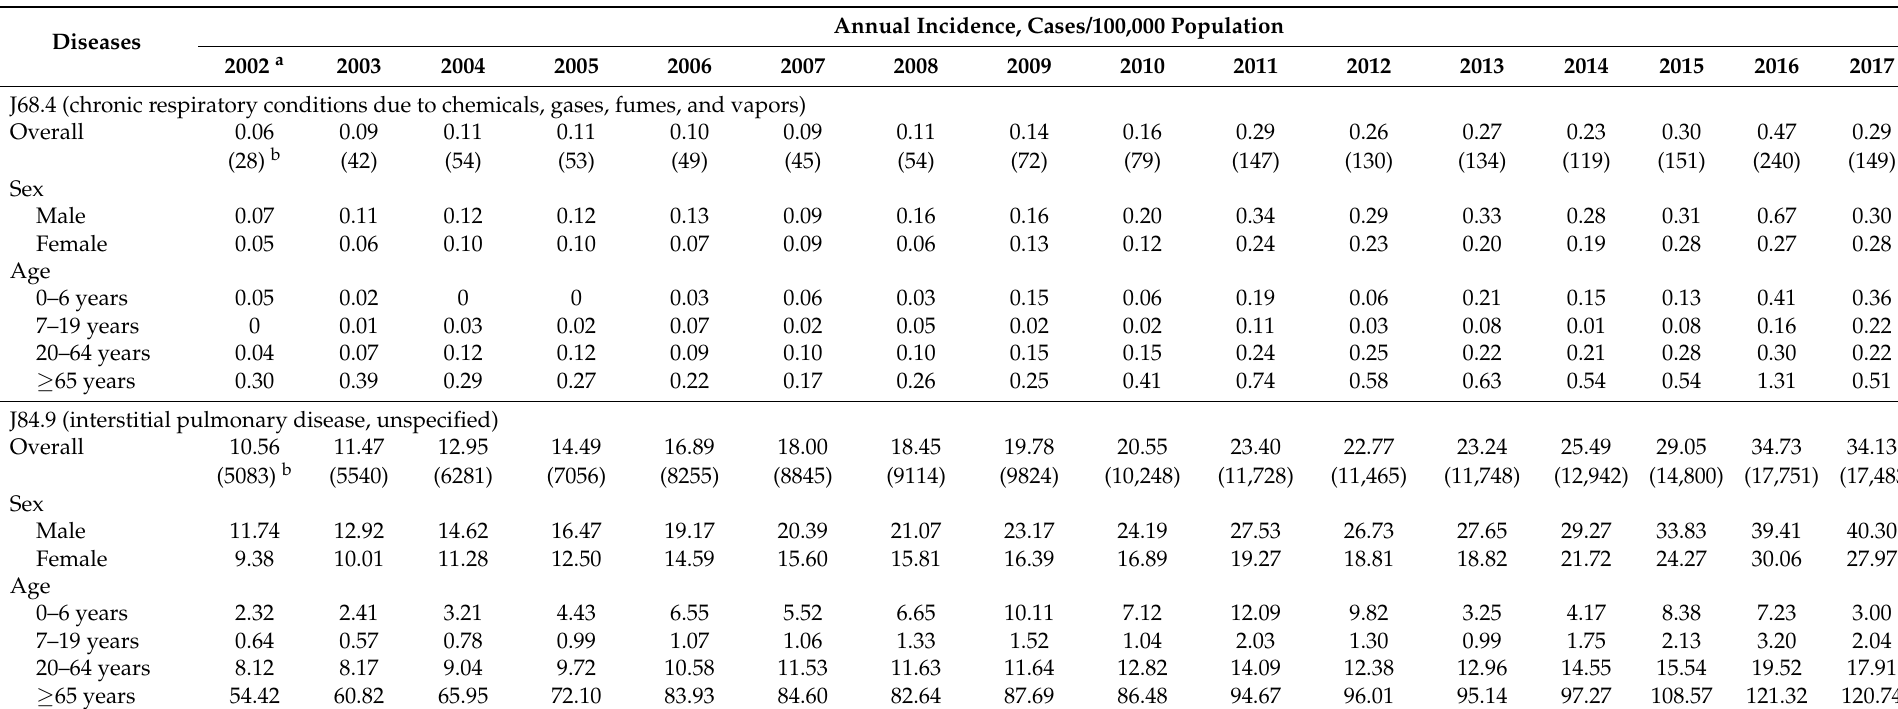
Table 2. Annual trends in the incidence of NHIS-recorded cases of J68.4, J84.9, J95.2, and S27.3 in South Korea during